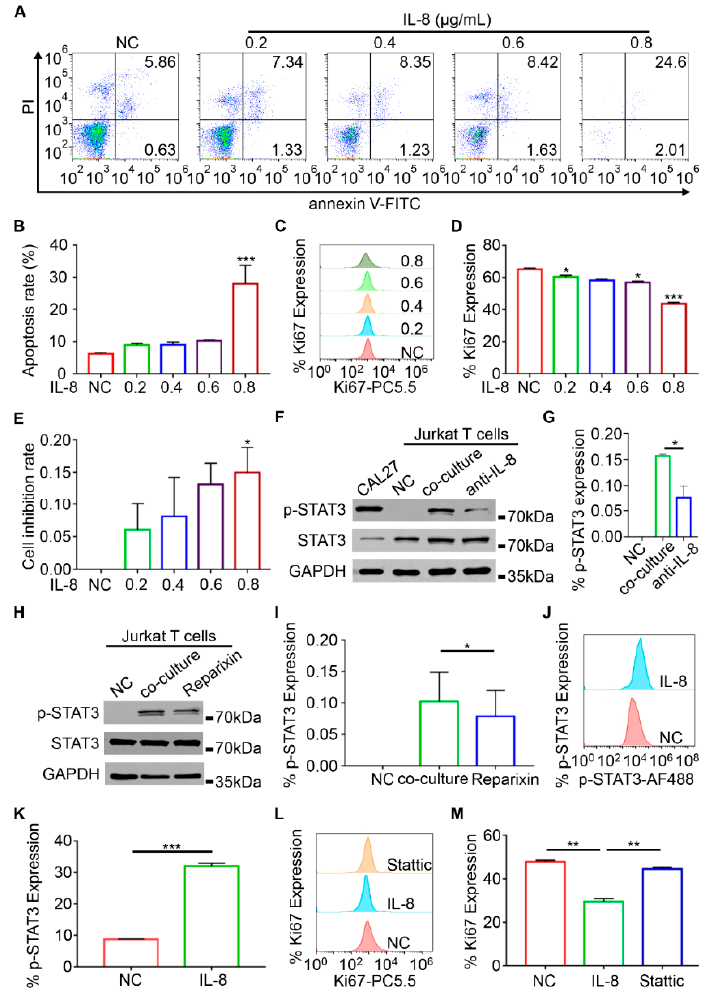
Figure 5. IL-8 inhibited the proliferation of T cells through the STAT3 signaling pathway. ( A , B) Flow cytometry analysis for cell apoptosis of Jurkat T cells stimulated with human recombinant IL-8 proteins (0, 0.2, 0.4, 0.6, and 0.8 µg/mL). ( C , D ) Flow cytometry analysis for the expression of Ki67 in Jurkat T cells stimulated with human recombinant IL-8 proteins (0, 0.2, 0.4, 0.6, and 0.8 µg/mL). ( E ) Inhibition rate of Jurkat T cells stimulated with human recombinant IL-8 proteins (0, 0.2, 0.4, 0.6, and 0.8 µg/mL) determined by CCK-8 assay. ( F , G ) Western blot analysis for p-STAT3 levels in CAL27 cells without treatment, Jurkat T cells without treatment, Jurkat T cells co-cultured with CAL27 supernatant, and Jurkat T cells co-cultured with CAL27 supernatant and 0.5 µg/mL anti-IL-8 neutralizing antibody treatment. ( H , I ) Western blot analysis for p-STAT3 levels in Jurkat T cells without treatment, Jurkat T cells co-cultured with CAL27 supernatant, and Jurkat T cells co-cultured with CAL27 supernatant and 100 ng/mL reparixin (inhibitor of the IL-8 receptors CXCR1/2). ( J , K ) Flow cytometry analysis for p-STAT3 expression levels in Jurkat T cells without treatment and Jurkat T cells stimulated with 0.8 µg/mL recombinant human IL-8 proteins. ( L , M ) Flow cytometry analysis for p-STAT3 expression levels in Jurkat T cells without treatment, Jurkat T cells stimulated with 0.8 µg/mL recombinant human IL-8 proteins, and Jurkat T cells stimulated with 0.8 µg/mL recombinant human IL-8 proteins and 6 µmol/L stattic (inhibitor of STAT3). * p < 0.05, ** p < 0.01, *** p < 0.001. Here, NC is negative control.